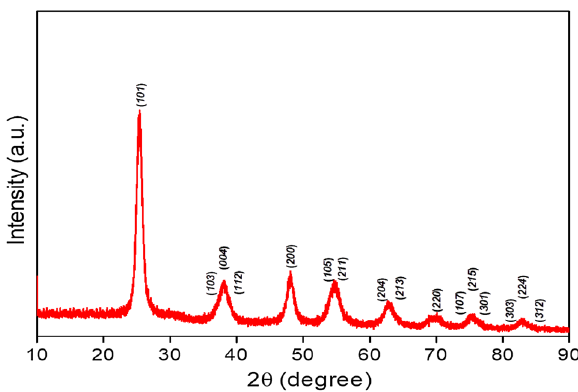
Fig. 1 XRD pattern of the B-TiO